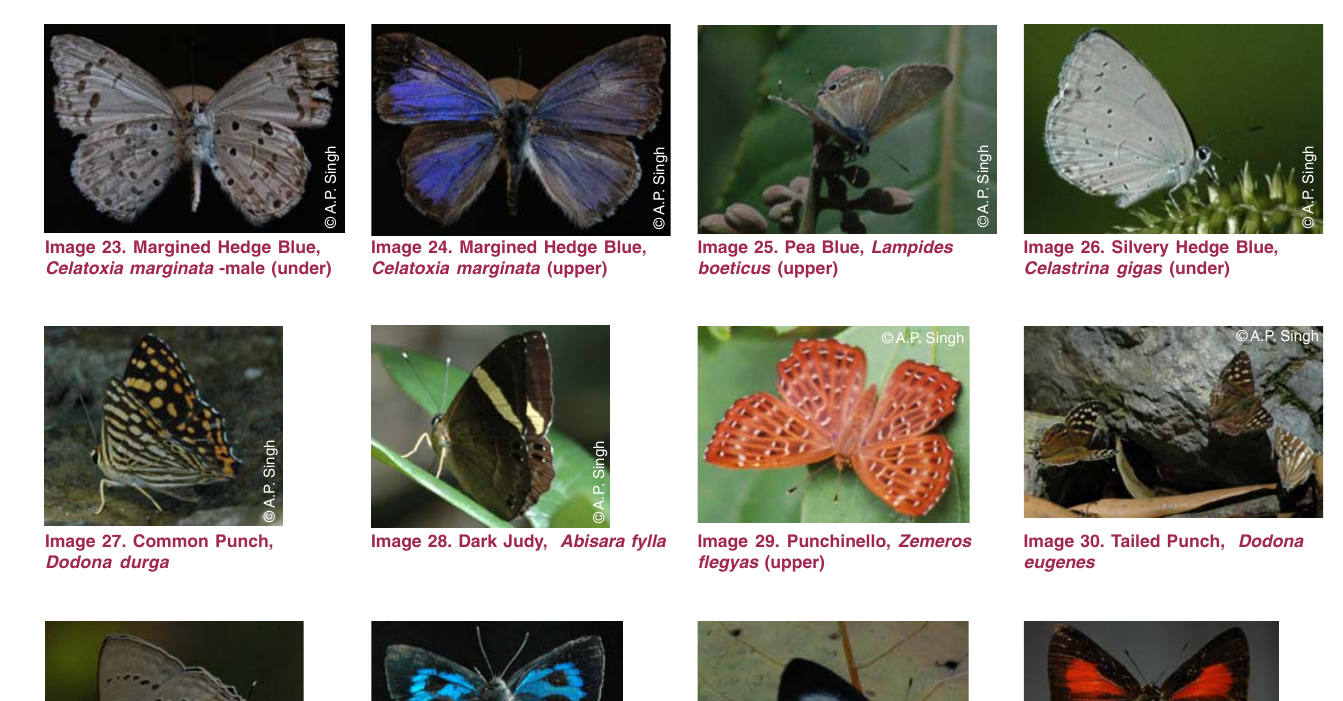
Image 22. Common Hedgeblue, Acytolepis puspa - female